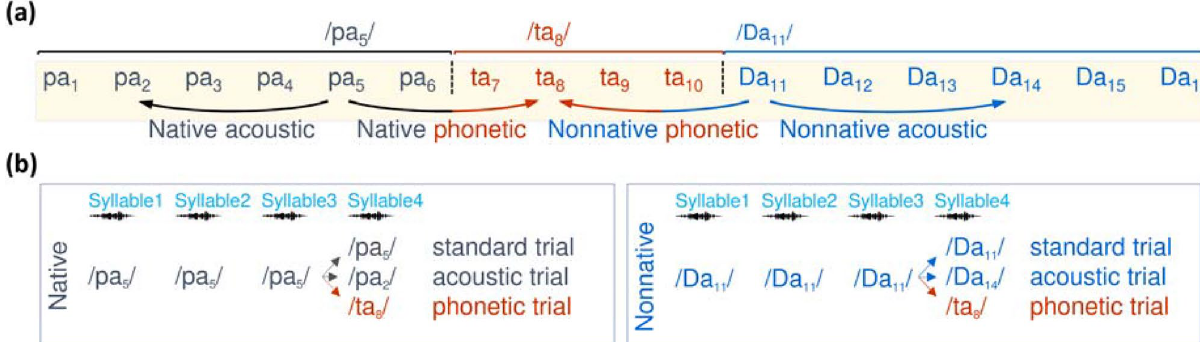
Figure 1. The native and nonnative phonetic distinction. In ( a ) we illustrate the synthetic consonant–vowel stimuli previously used to study categorical perception in English 13 , Hindi 14 , and Spanish-speakers 15 . This continuum comprises 16 steps (i.e. syllables) equidistant along the voiced place-of-articulation dimension from the bilabial /b/ to the dental /d/ and to the retroflex /D/, associated with the vowel /a/. Along the continuum, adult native English-speakers perceive two phonetic categories (Step1–Step6 as /ba/ and the following as / da/) while adult native Hindi-speakers perceive three (Step1–Step6 as /ba/, Step7–Step10 as /da/, and Step11– Step16 as retroflex /Da/). Adult Spanish-speakers also perceive two categories, however from Step1 to Step6 are perceived as /pa/ and the next as /ta/, due to a shorter voice onset time for these syllables in Spanish. In grey and orange, we indicate the syllables perceived as the native /pa/ and /ta/ respectively by Spanish-speaking adults, and in blue, those perceived as the nonnative /Da/ by Hindi-speaking adults. The phonetic boundaries are indicated by black vertical dotted lines. The arrow below the continuum indicates the stimulus we compared in this study to evaluate the response to phonetic and acoustic changes at the native and nonnative boundaries. In ( b ) we illustrate the structure of the trials. Each trial comprised the auditory presentation of four 275 ms long syllables, one every 600 ms separated by silence. The first 3 syllables were always identical, to induce habituation, while the 4th syllable remained the same in standard trials, changed to a syllable from a different phonetic category in phonetic trials or changed to a syllable of the same category in acoustic trials. Because any change between phonemes conveys a change at the acoustic and linguistic level, the subtraction of the brain response for standard and acoustic trials to the response for phonetic ones, at the native and nonnative phonetic boundaries, allowed us to quantify the purely linguistic component of the